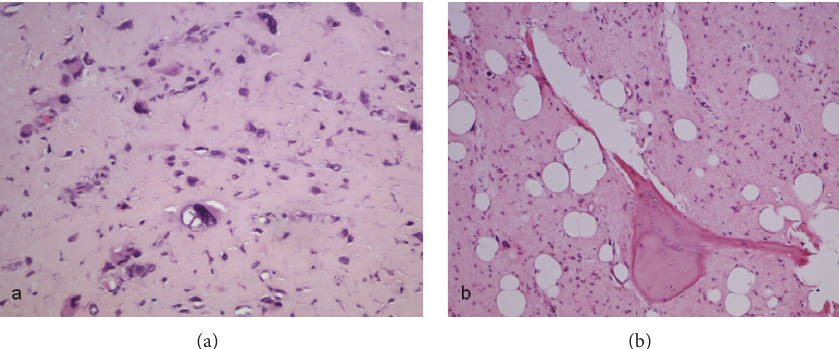
Figure 1: Histopathological pictures of the last high-grade osteosarcoma of the right distal femur in 2005 (a) before and (b) after chemotherapeutic